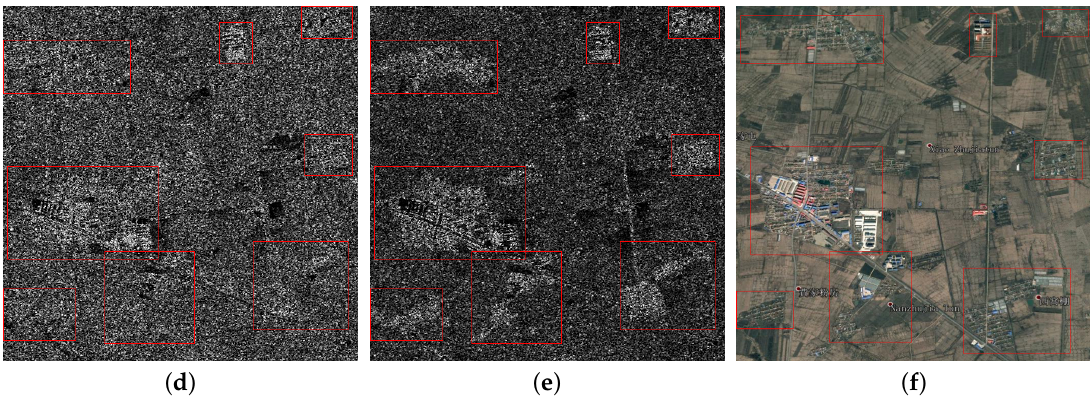
Figure 2. ( a ) HH; and ( b ) HV are full polarization GF-3 images of Jilin province (13 July 2017) imaged in SS mode with 25 m resolution covering 83,359.2 square kilometers. Image size is 10,953 × 12,177 pixels. ( c ) The optical image of the same area obtained from Google Earth. ( d – f ) Selected areas of ( a – c ). Areas in red mark are buildings and the rest is cropland.